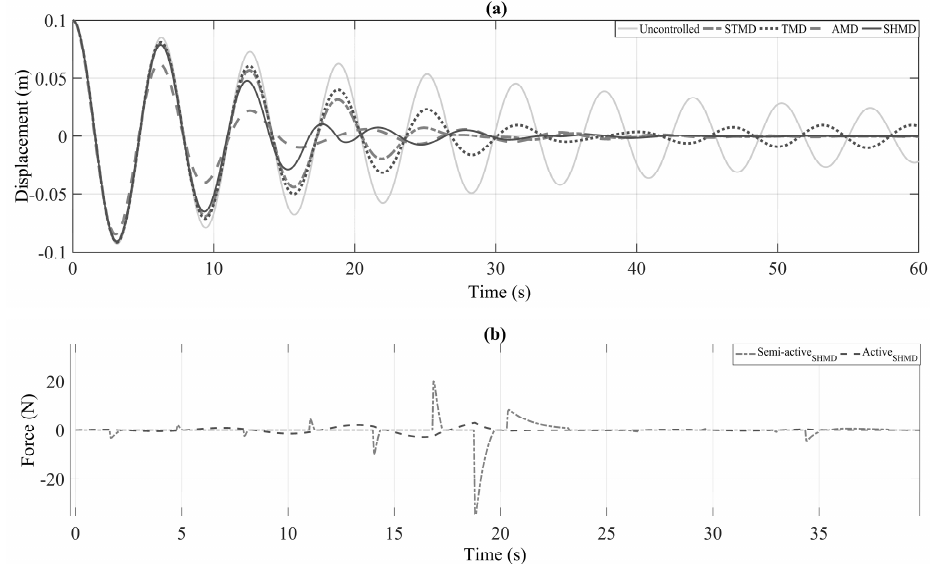
Figure 7. ( a ) Displacement response time history of different control configurations; ( b ) control signal of active component and semi ‐ active component of the hybrid configuration.